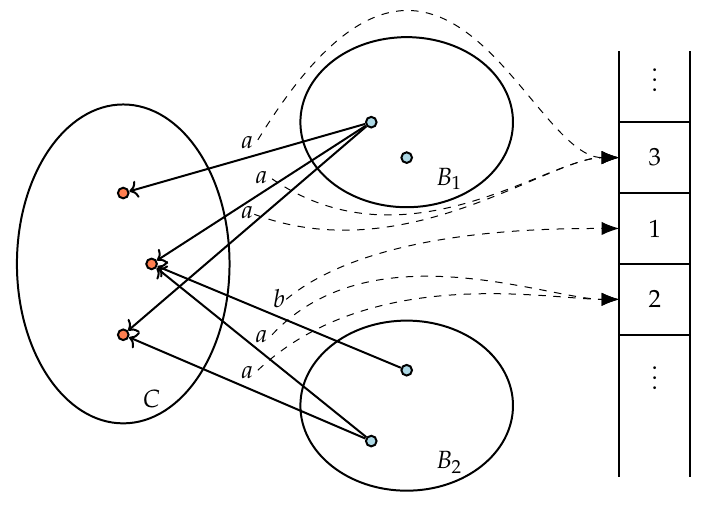
Figure 3. Transitions with state _ to _ constellation _ cnt stored in a global